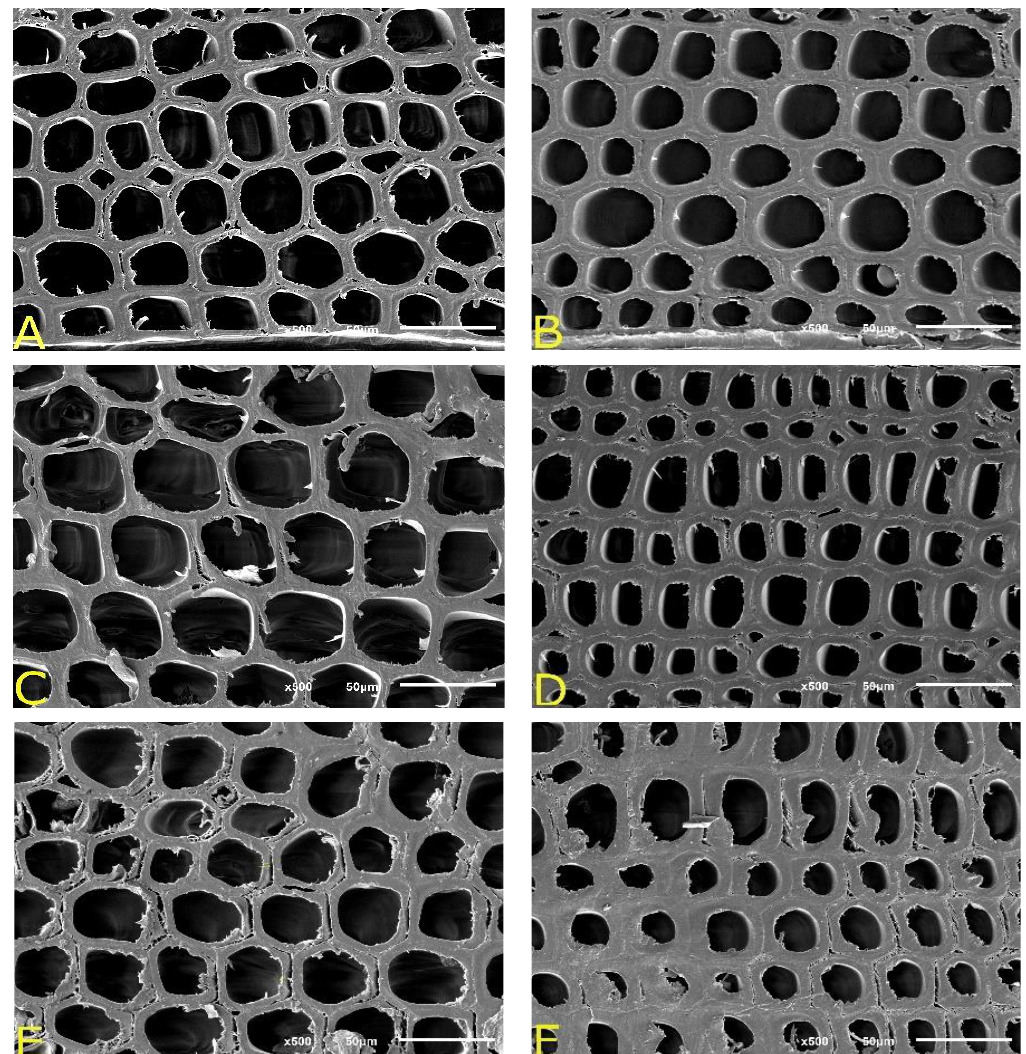
Figure 6. SEM images of radiata pine wood samples: untreated ( A ) earlywood (EW); ( B ) latewood (LW). Samples subjected to tensile creep: ( C ) EW section of a piece loaded 1170 N; ( D ) LW section of a piece loaded 1170 N; ( E ) EW section of a piece loaded 1530 N; ( F ) LW section of a piece loaded 1530 N.